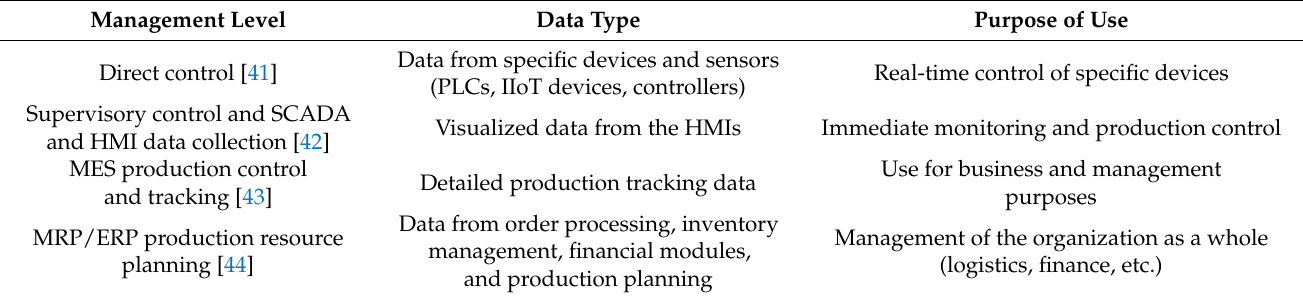
Table 1. An overview of the data produced at the heterogeneous management